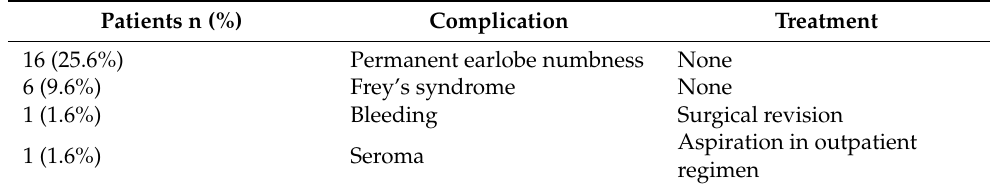
Table 2. Postoperative